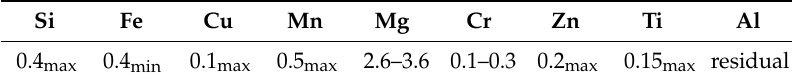
Table 1. Chemical composition (wt.%) of 5754 aluminum